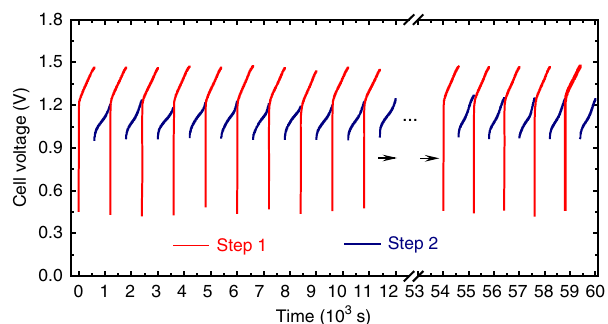
Fig. 3 Cycle pro fi le of two-step chlor-alkali electrolysis. Chronopotentiometry curve (cell voltage vs. time) of the cycle between Steps 1 and 2 with an applied current of 100 mA and a step time of 600 s, where the chronopotentiometry data of Step 1 (H 2 +NaOH generation) and Step 2 (Cl 2 generation) are labelled with the red and blue